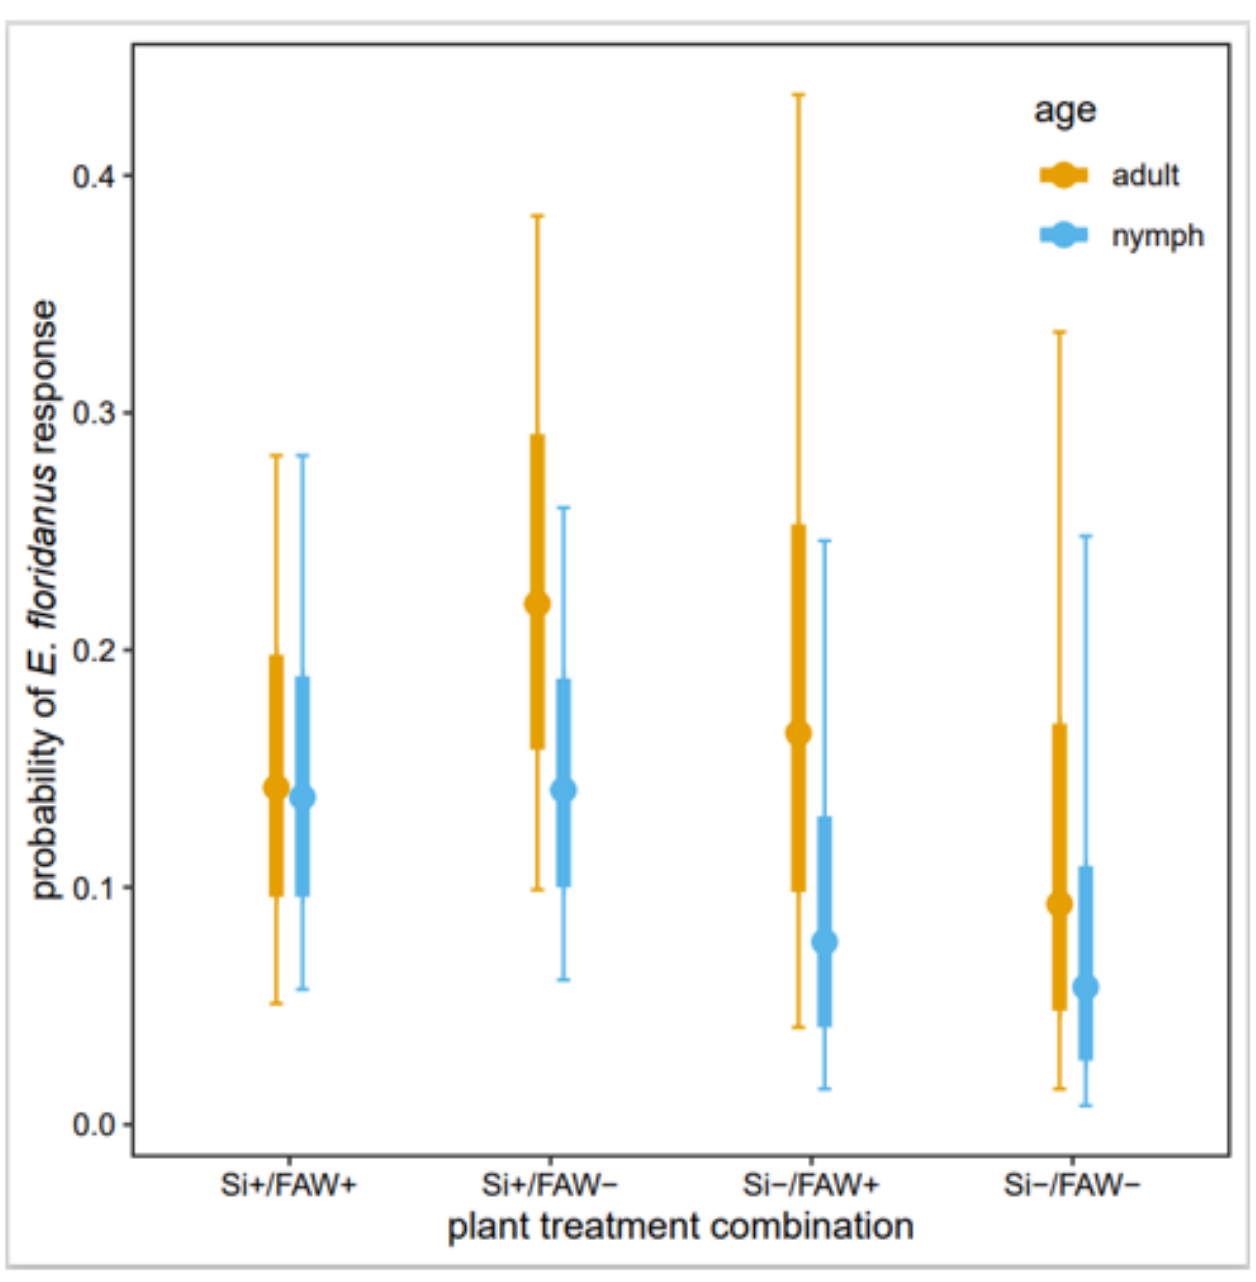
Figure 3. Posterior estimates of the probability of response by adult (orange points and bars) and nymph (blue) of E. floridanus to each of the four treatments. Median estimates are indicated with points; thick error bars represent 66% quantile credible intervals, and thin error bars represent 95% quantile credible intervals. FAW = fall armyworm; Si+FAW+ = silicon treated and infested; Si+FAW- = silicon treated without infestation; Si-FAW+ = silicon deprived and infested; Si-FAW- = silicon deprived without infestation